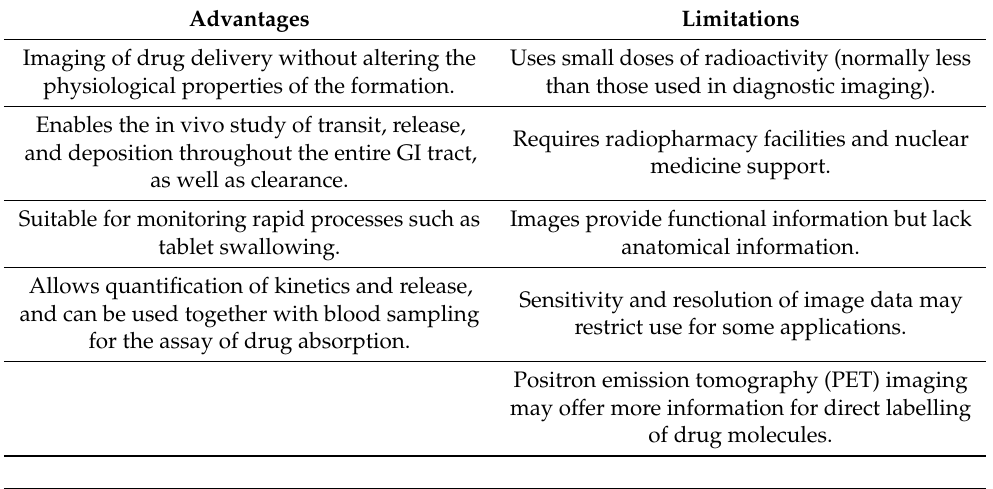
Figure 3. A series of gamma camera images showing a gelatin capsule formulation (shown in red pixels) stuck in the throat of a healthy volunteer. The subject was not aware that swallowing had not been completed for over 60 min. Table 1. Advantages and limitations of